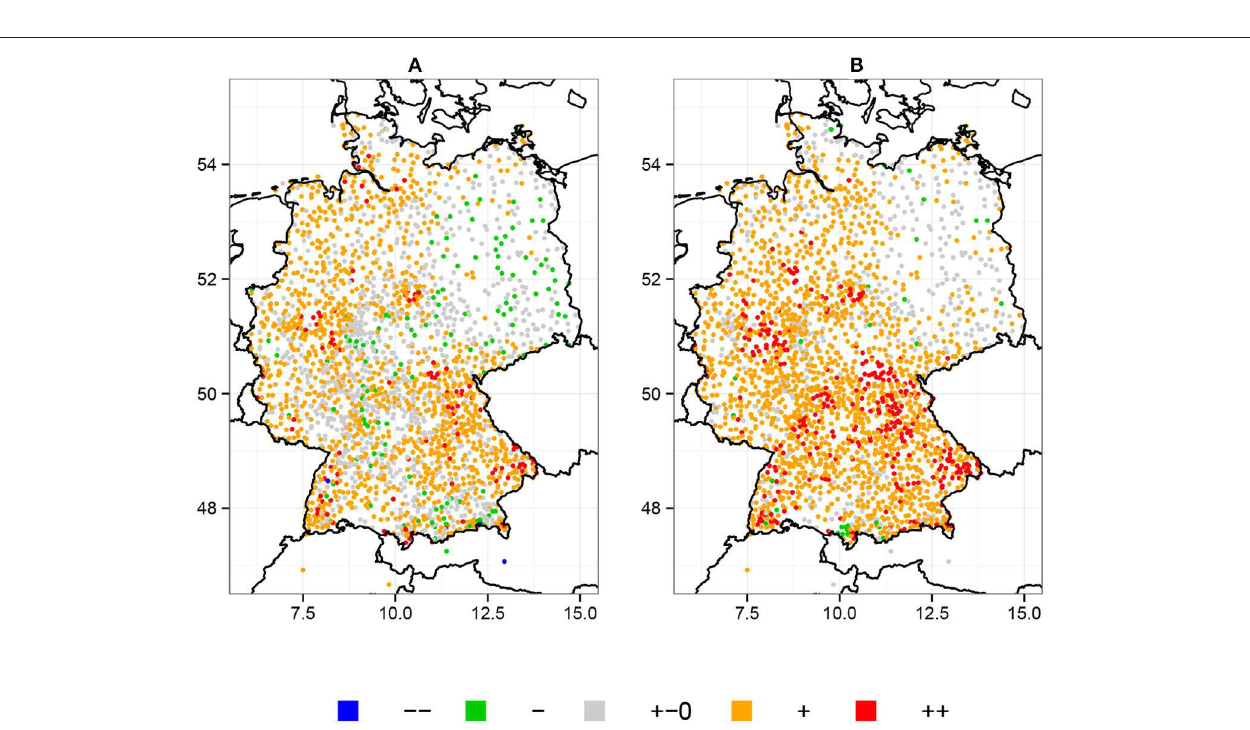
FIGURE 4 | Trends in the intensity of heavy precipitation over Germany. Trends are categorized into large positive trend (++, x > 0.04 mm/yr), small positive trend (+, x > 0.01 mm/yr), nearly no change (+–0, –0.01 mm/yr < x < 0.01 mm/yr), small negative trend (–, x < –0.01 mm/yr), or large negative trend (–, x < –0.04 mm/yr), where x is a place holder for (A) β 1 and (B) µ 1